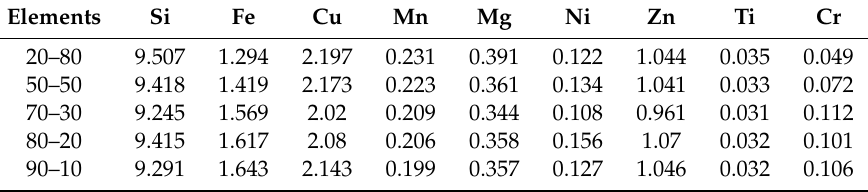
Table 2. Chemical composition of experimental alloys AlSi9Cu3 alloy